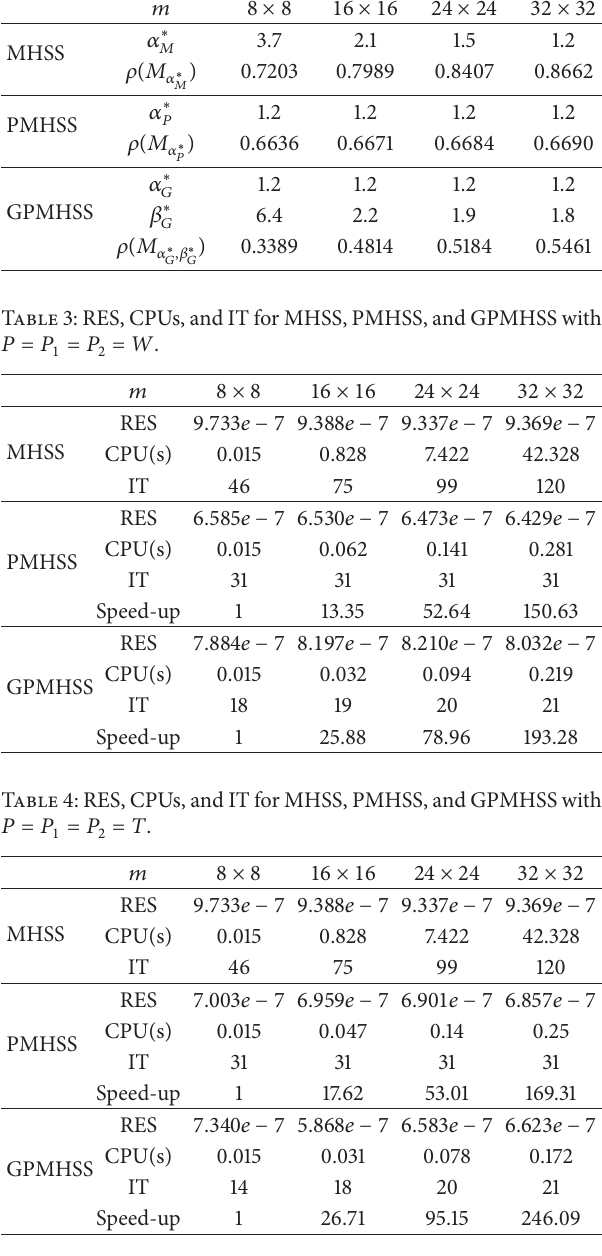
Table 2: The experimentally optimal parameters and the spectral radii for the iteration matrices of MHSS, PMHSS, and GPMHSS with 𝑃 = 𝑃 1 = 𝑃 2 = 𝑇 .